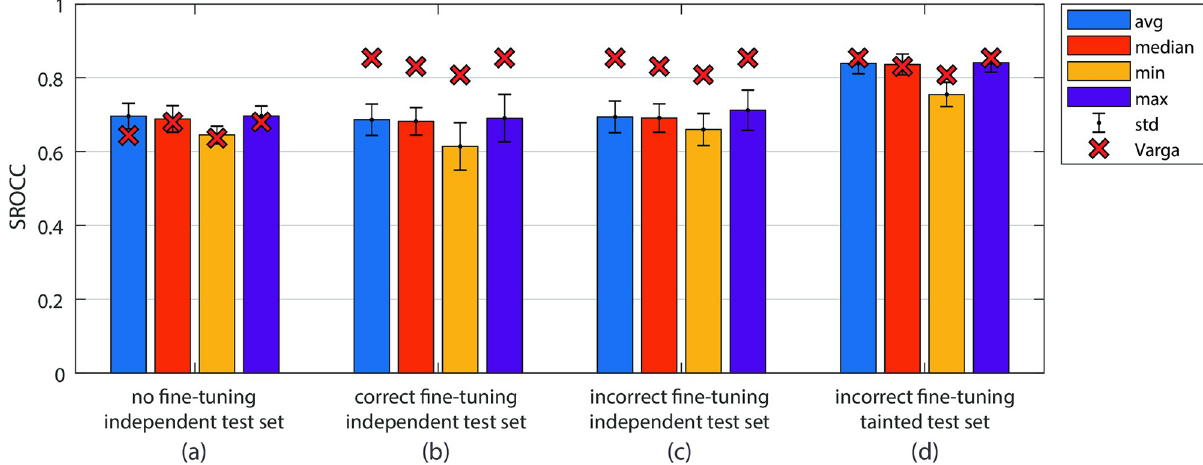
Fig 6. Performance comparison of SVRs trained using different kernel functions from our reimplementation. Chart (a) shows the results when no fine-tuning is used for the feature extraction network. The performance with correctly applied fine-tuning is shown in the chart (b), which is also the true performance of the approach. Charts (c) and (d) depict the performance when fine-tuning is performed with data leakage. The bars represent the average performance of five random training, validation, and test splits. Independent test sets are chosen prior to fine-tuning, and for (d) also tainted test sets are chosen at random before SVR training. The red cross markers represent the corresponding numbers reported in [9], as measured from the figures in the paper.